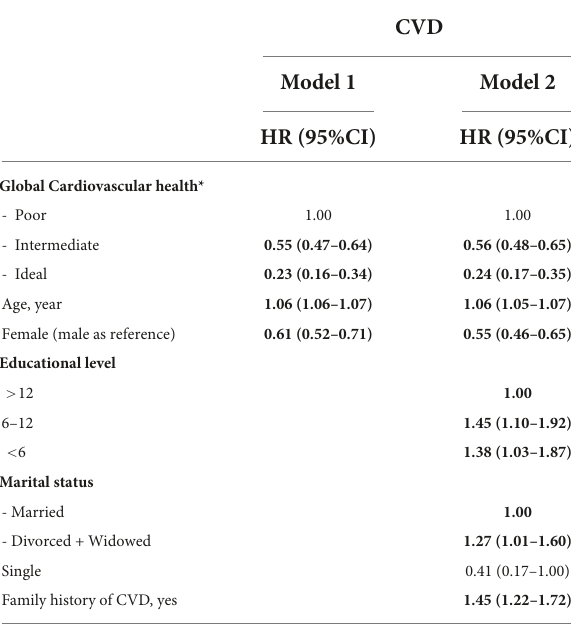
TABLE 5 Multivariable hazard ratios (HR) and 95% confidence intervals (CI) for the association between global cardiovascular health categories *, CHD, stroke, sudden death and all- cause mortality: Tehran Lipid and Glucose Study (TLGS),